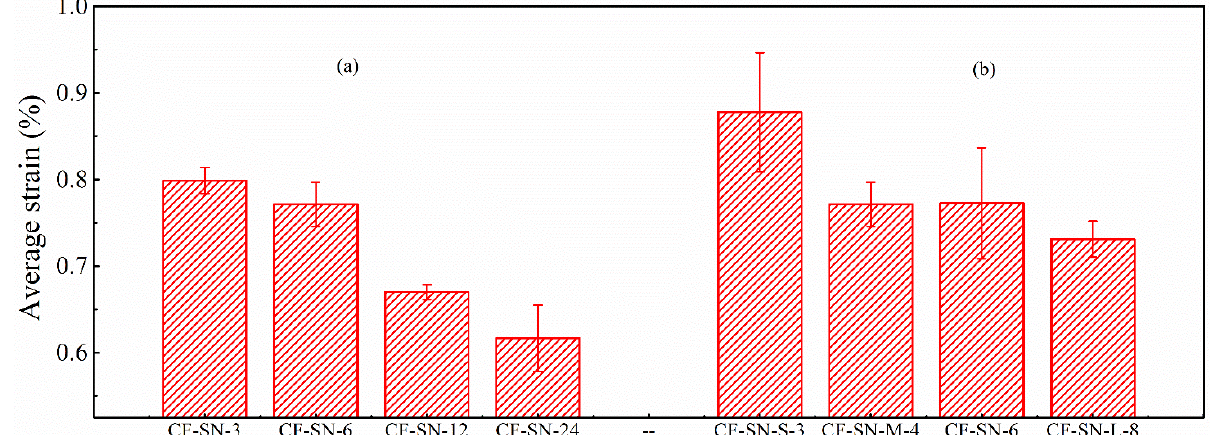
Figure 7. Comparison of the average strain of specimens with different notch sizes. ( a ) Different notch size for the same specimen size. ( b ) Different notch size for the same size ratio, W /2 C ; the strain concentration at the crack tip does not increase linearly.